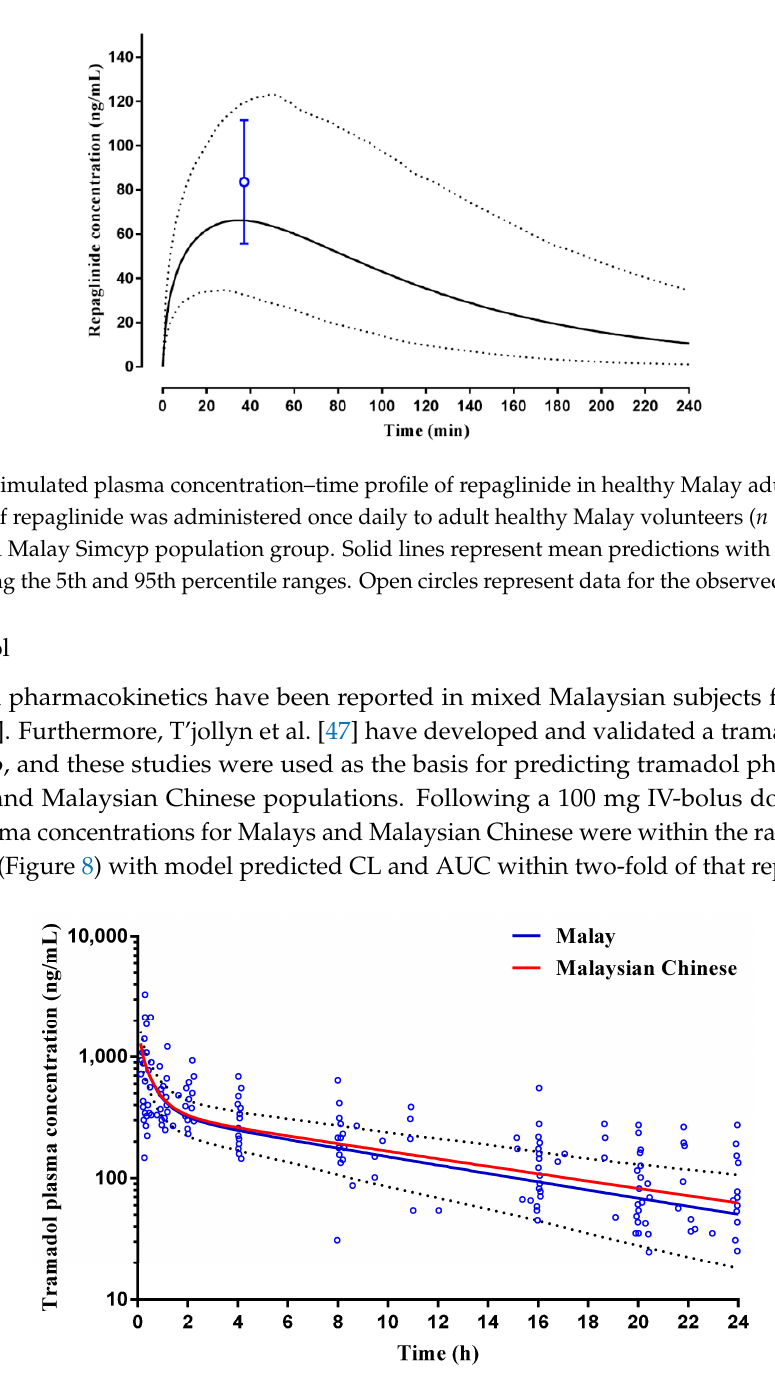
Figure 8. Simulated plasma concentration–time profile of tramadol intravenous bolus dosing in Malay and Malaysian Chinse subjects. An IV-bolus dose of 100 mg tramadol was administered to adult healthy mixed Malaysian volunteers ( n = 100) using the custom Malaysian (Malay and Malaysian Chinese) Simcyp population group. Solid lines represent mean predictions with dotted lines represent the 5th and 95th percentile ranges. Open circles represent data for the observed study [46].